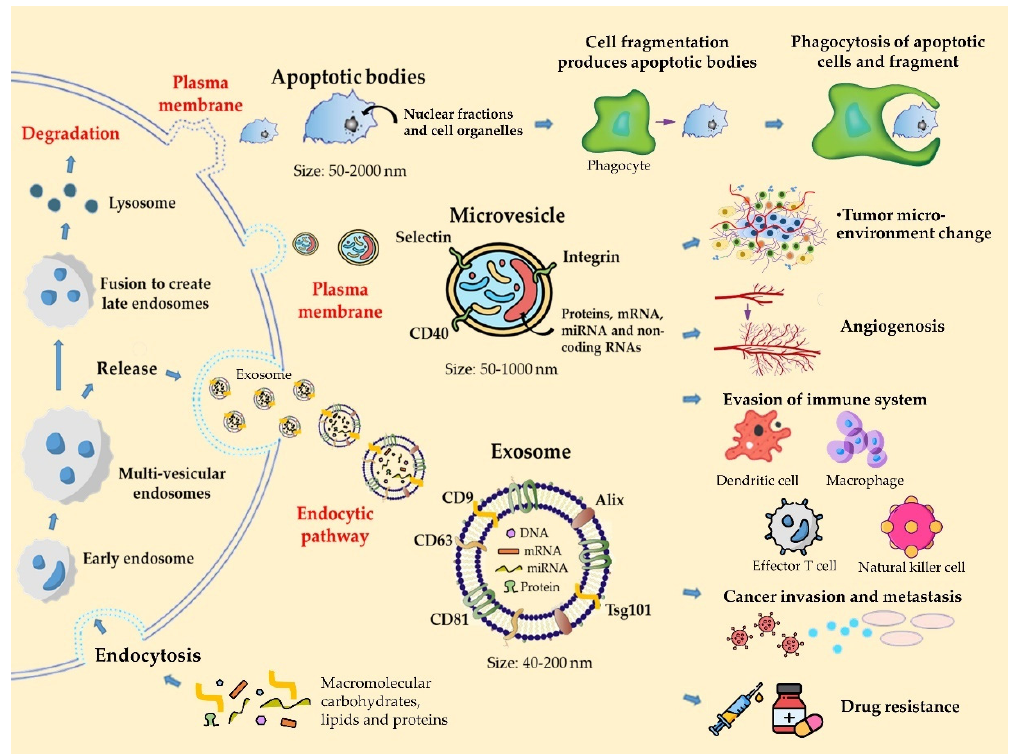
Figure 1. Origin, classification, composition, and biological function of EVs.